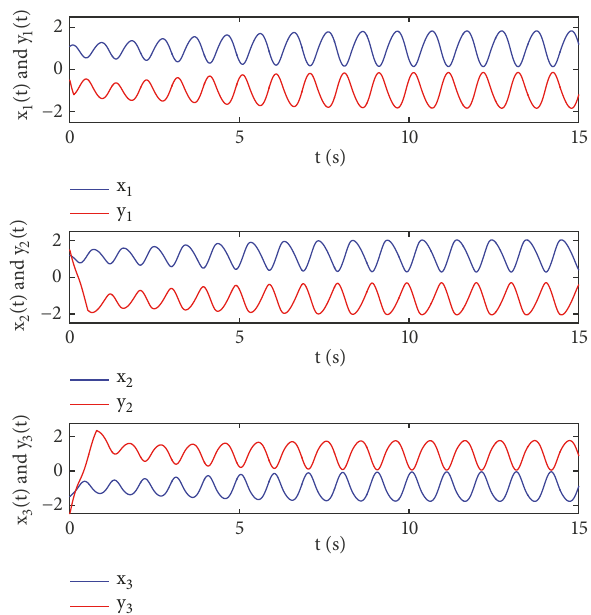
Figure 3: State trajectories of master-slave systems with 𝜉 = -1.